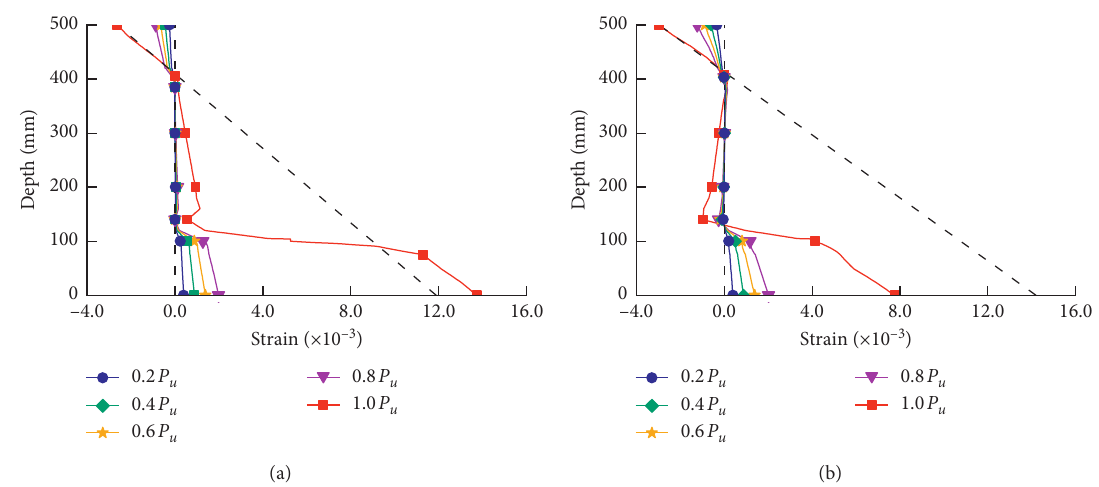
Figure 13: Strain distributions through beam sections of S1: (a) section A-A; (b) section B-B.